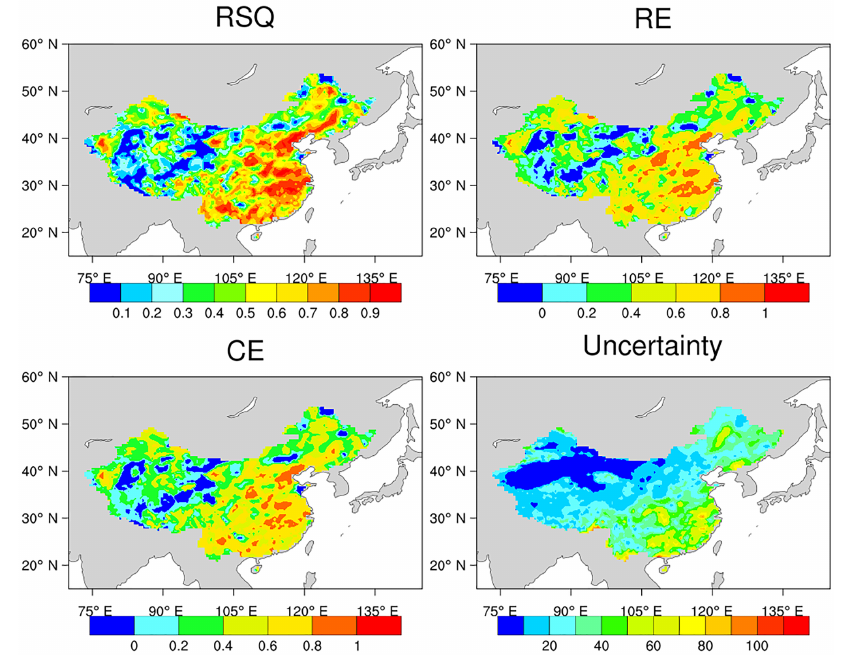
Figure 3. Skills of the reconstructed MJJAS mean precipitation anomalies in China for the 1961–1990/1991–2000 calibration/verification period. The r 2 is the square of the Pearson product–moment correlation coefficient, the RE and CE are the reduction of error and the coeffi- cient of efficiency, and the uncertainty is characterized by the standard deviation of the residual between the reconstructed and instrumental precipitation data during the verification